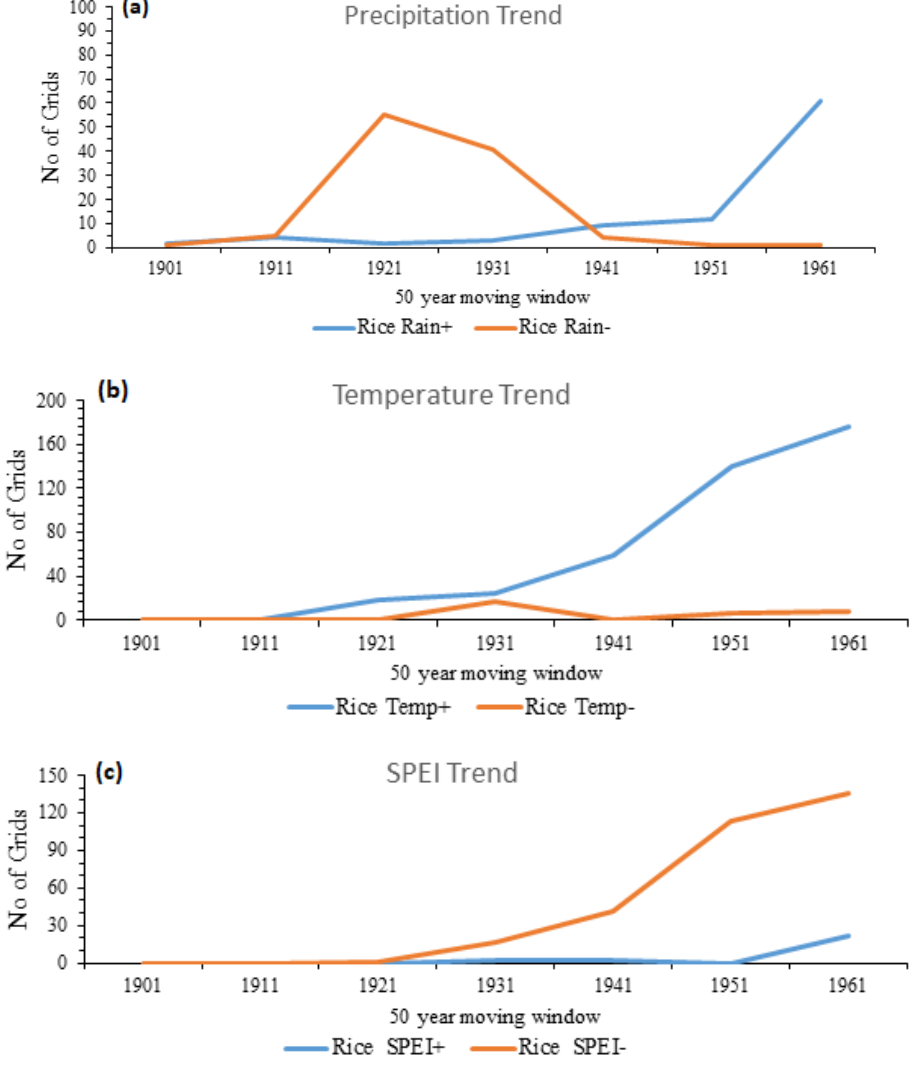
Figure 8. The number of grid points at which significant changes in ( a ) precipitation, ( b ) mean temperature, and ( c ) SPEI during rice-growing season for di ff erent 50-year windows during